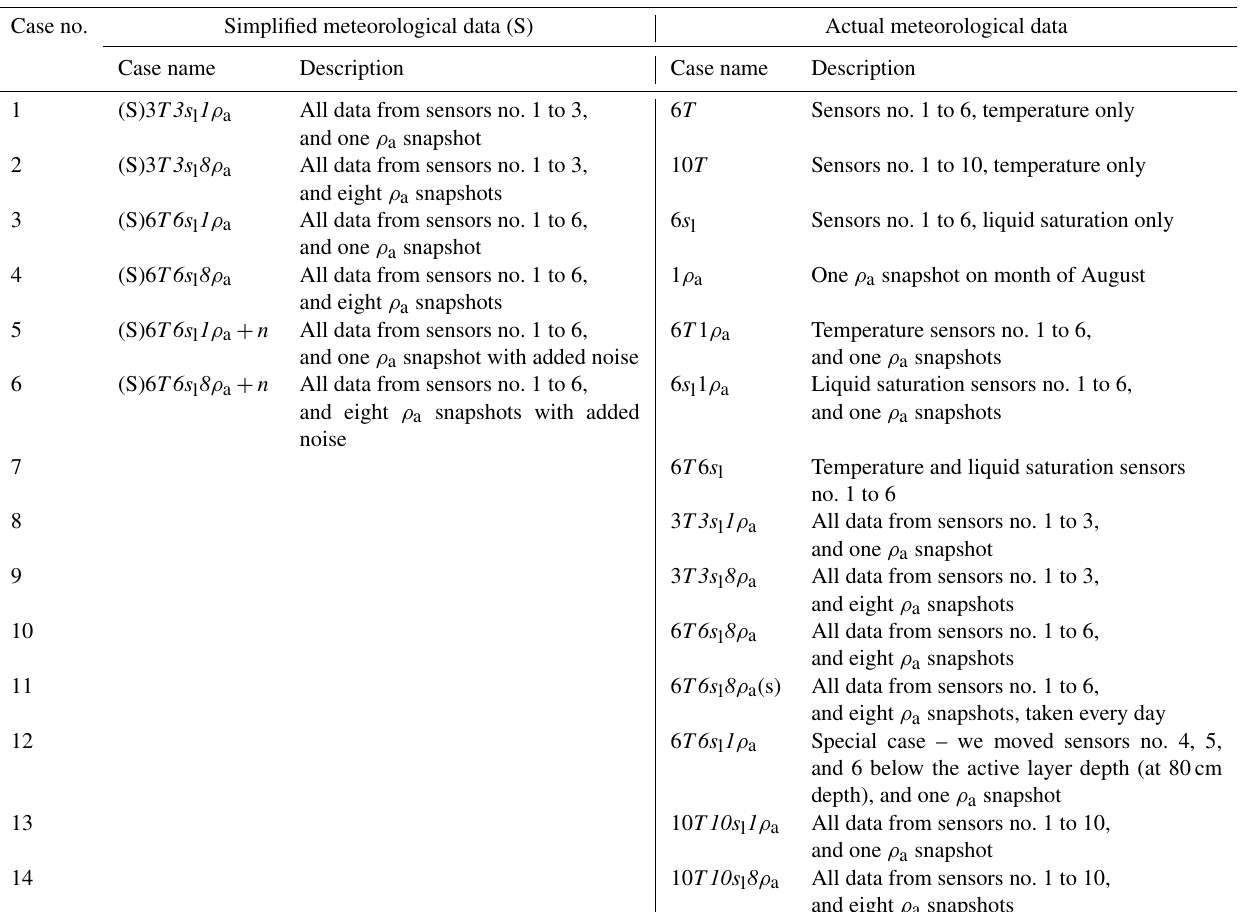
Table 2. Description of all PE cases used in this study. The numbers before T and s l correspond to the number of sensors used. The number before ρ a corresponds to the number of apparent resistivity snapshots used. n stands for noise added to the synthetic measurements. (S) corresponds to runs driven by simplified meteorological data. (s) represents daily ρ a snapshots. Case